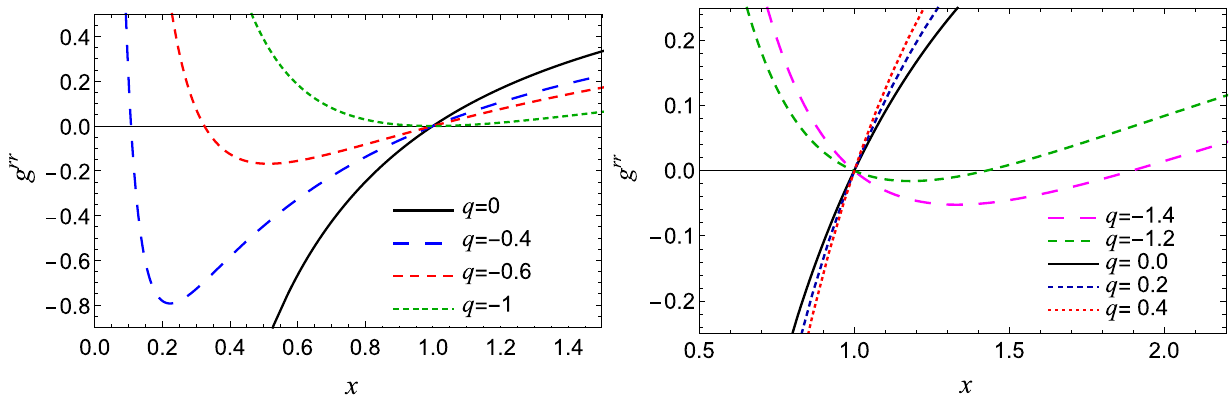
Fig. 1 The horizons of the hairy black hole in Horndeski gravity. When −∞ < q < 0 the black hole admits both event horizon x + and Cauchy horizon x − , otherwise has only event horizon for q >